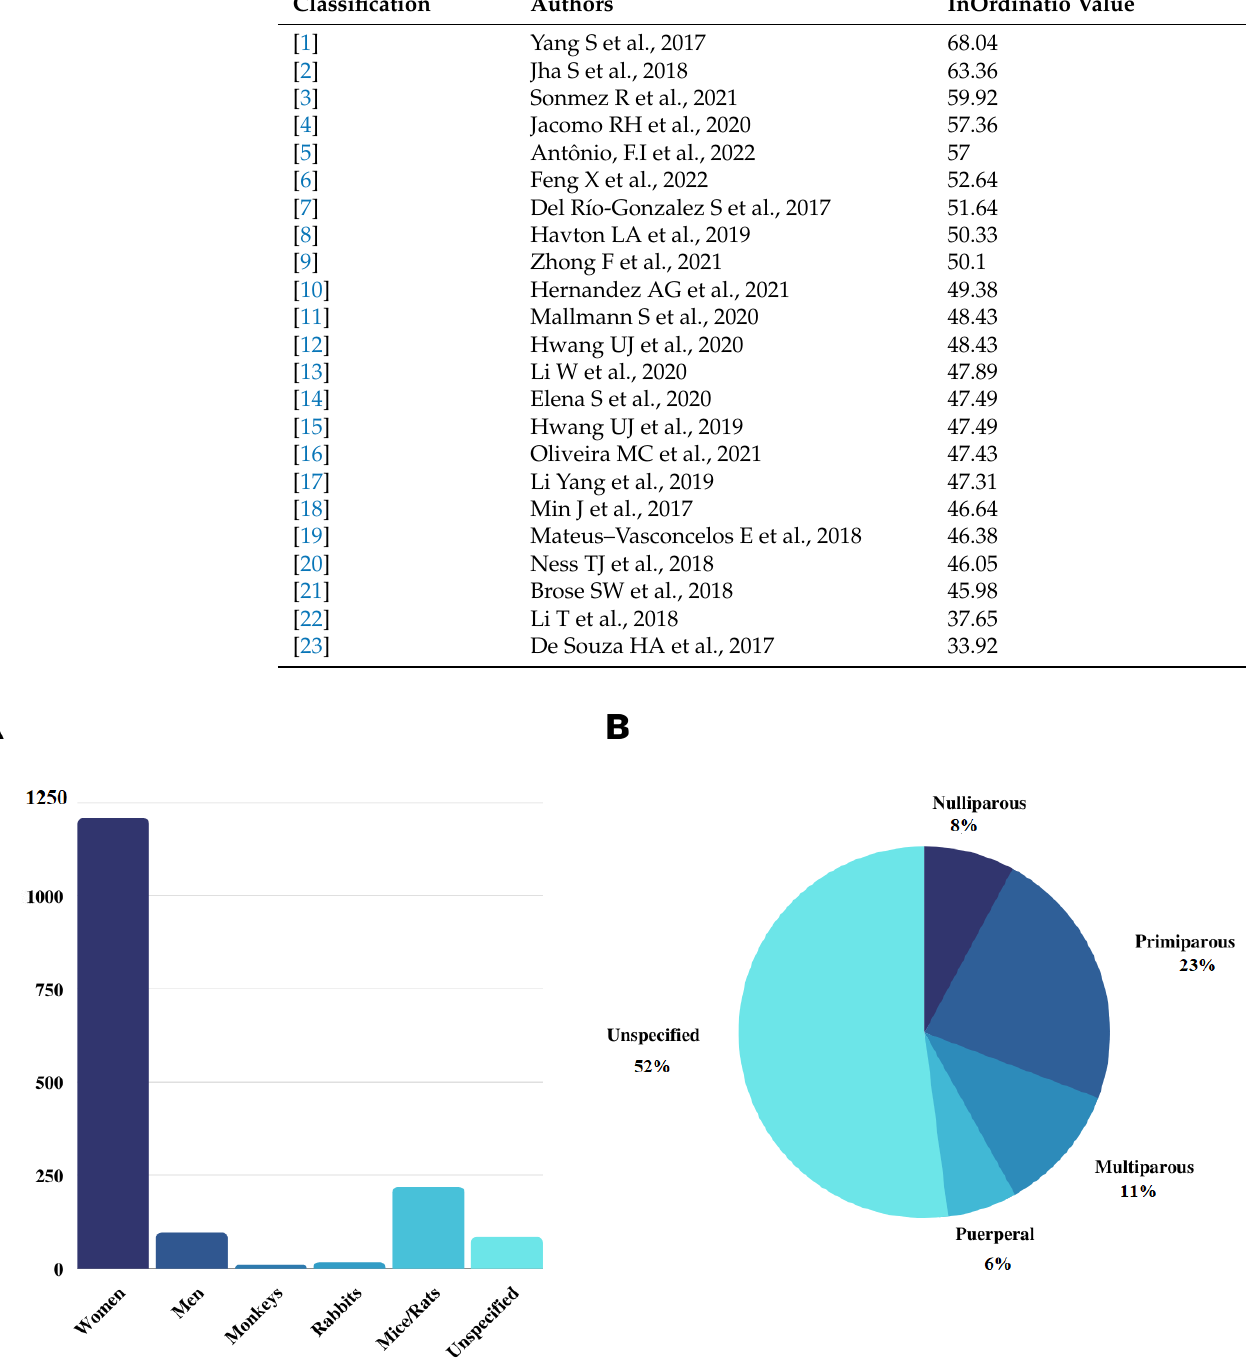
Table 2. Methodological InOrdinatio classification of the articles found during the search. Classification